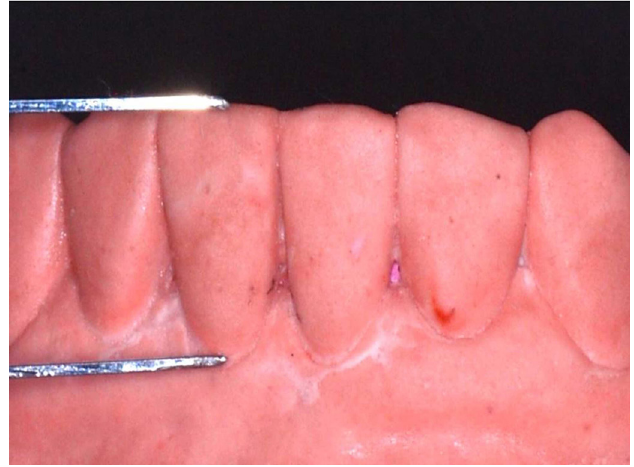
Fig.2. Measurement of LCC of the four mandibular